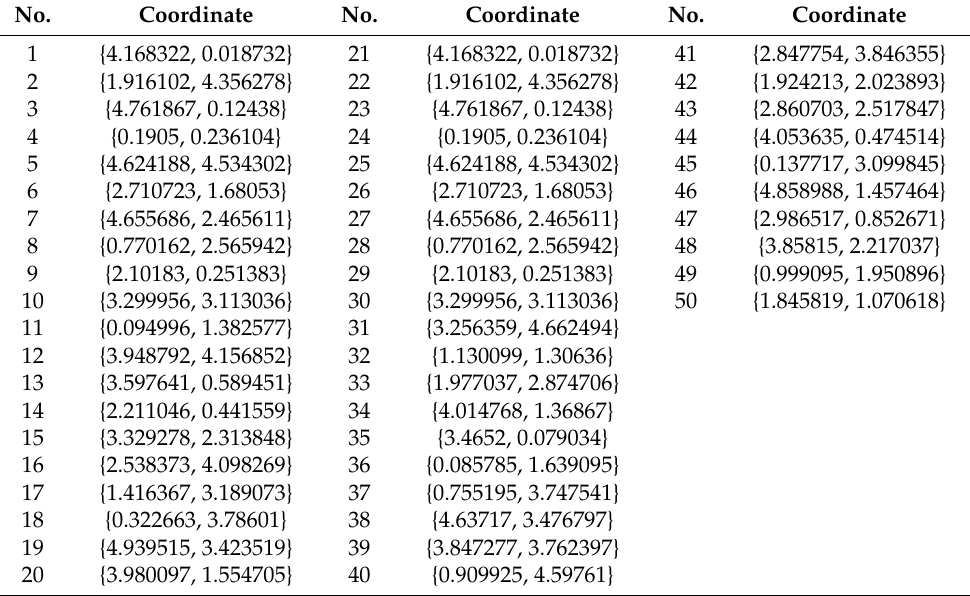
Table 1. The coordinates of 50 random points on the thin